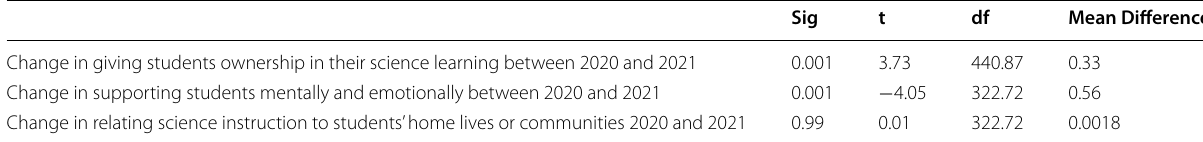
Table 4 T-test Results of Teachers Reported Incorporation of Student Agency, Prior Experiences, and Mental/Emotional Health Between 2020 and